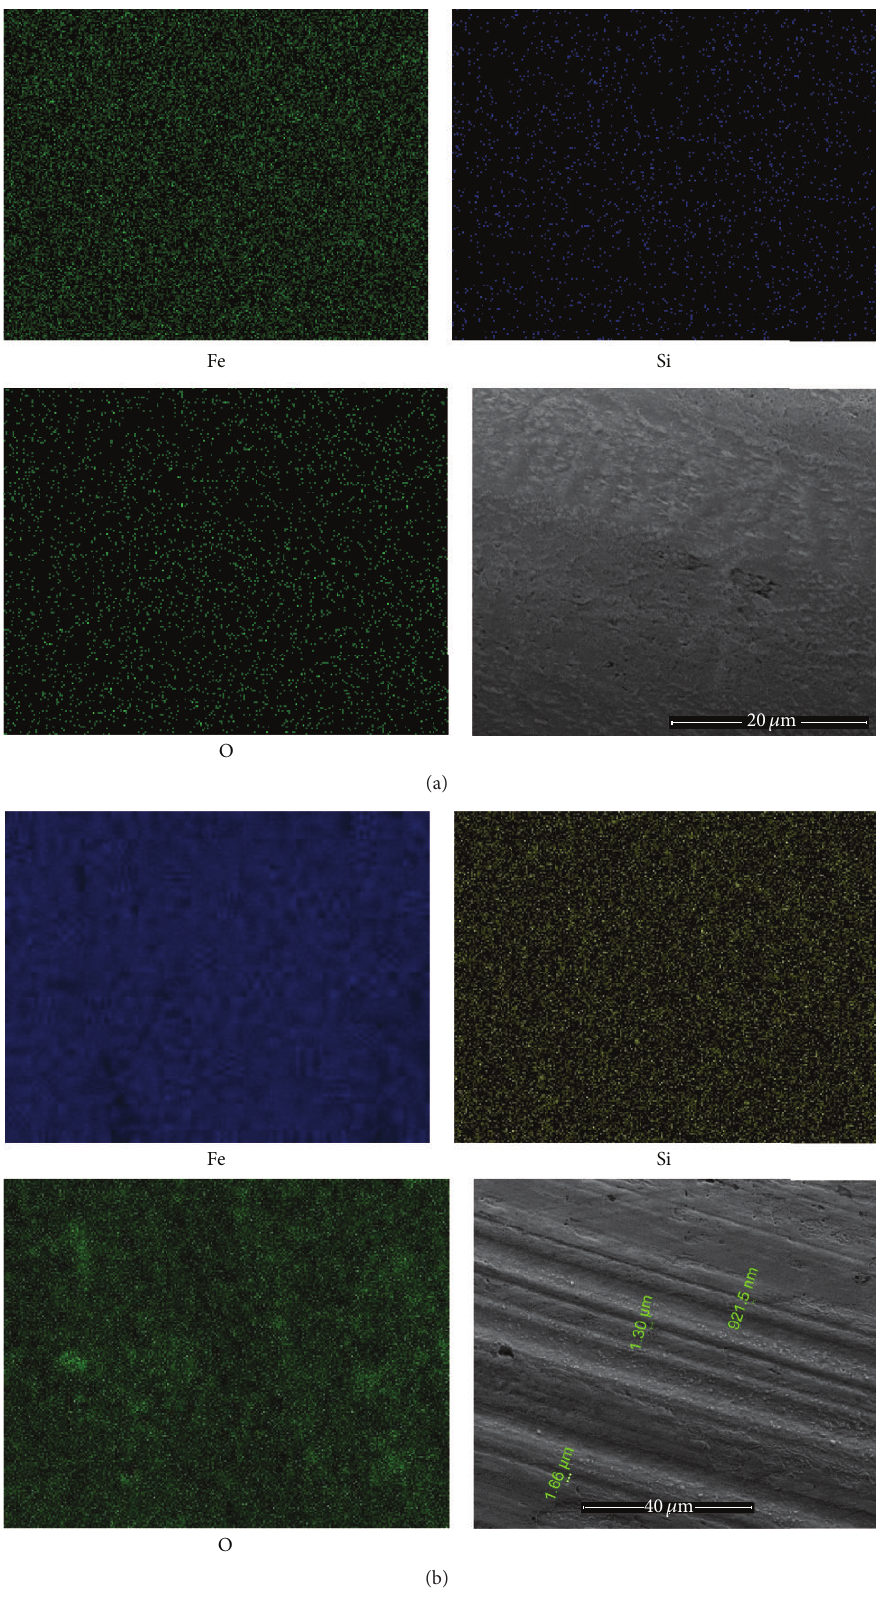
Figure 10: Worn surface mapping of the balls used in (a) tests numbers 5a, 5b and (b) test number 2 demonstrating the presence of Fe, Si, and